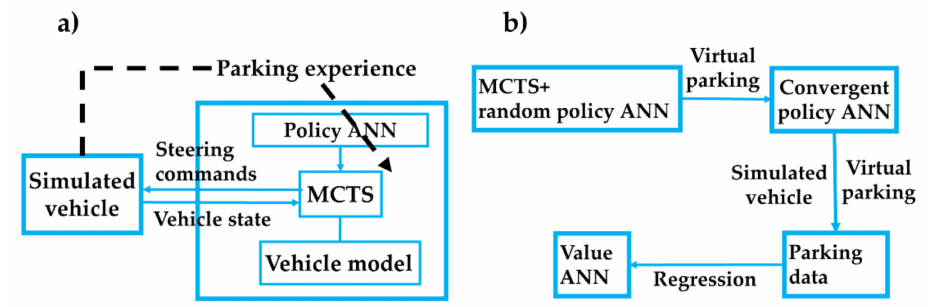
Figure 5. Training pipeline of the proposed method with ( a ) the pre-train method using MCTS and the policy ANN [10]; and ( b ) the training pipeline to obtain the value ANN.